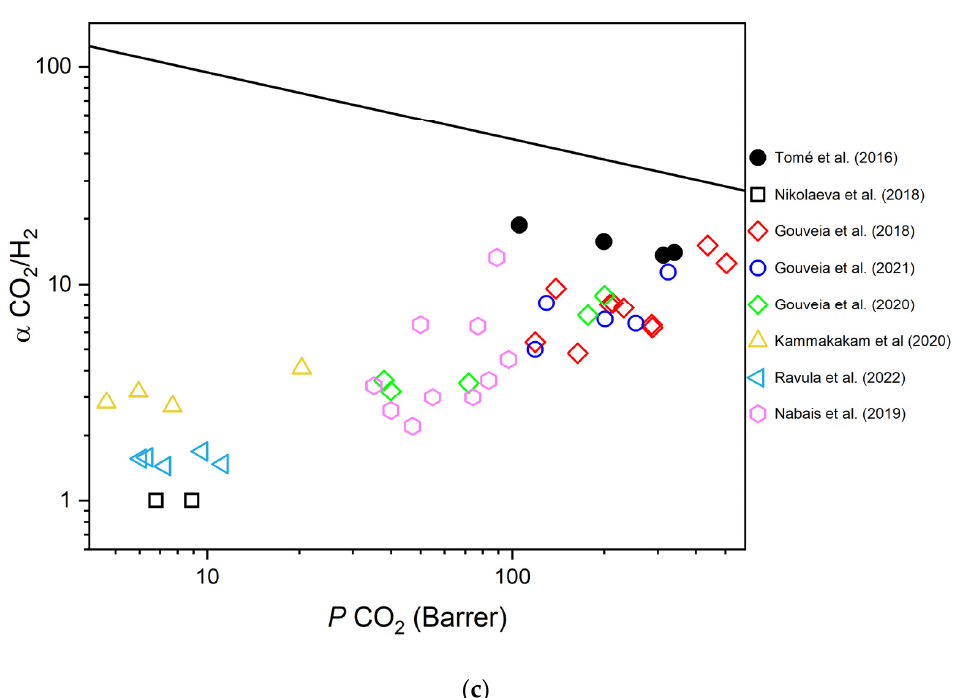
Figure 2. Robeson plots of PIL-based membranes for the: ( a ) CO 2 /N 2 separation; ( b ) CO 2 /CH 4 separation; and ( c ) CO 2 /H 2 separation. The indicated works correspond to the following references: Tomé et al. (2016) [15]; Nikolaeva et al. (2017) [28]; Nikolaeva et al. (2018) [29]; Yin et al. (2020) [30]; Tomé et al. (2017) [31]; Teodoro et al. (2018) [32]; Tomé et al. (2018) [33]; Gouveia et al. (2018) [34]; Gouveia et al. (2021) [35]; Gouveia et al. (2020) [36]; Kammakakam et al. (2020) [37]; Vijayakumar et al. (2021) [38]; Zhang et al. (2017) [39]; Nellepalli et al. (2019) [40]; Wang et al. (2021) [41]; Ravula et al. (2022) [42]; Dunn et al. (2019) [43]; Nabais et al. (2019) [44]; Sampaio et al. (2020) [45] and Niko- laeva et al. (2020) [46]. Table 1. CO 2 Separation Performance of Different Types of PIL-Based Membranes.